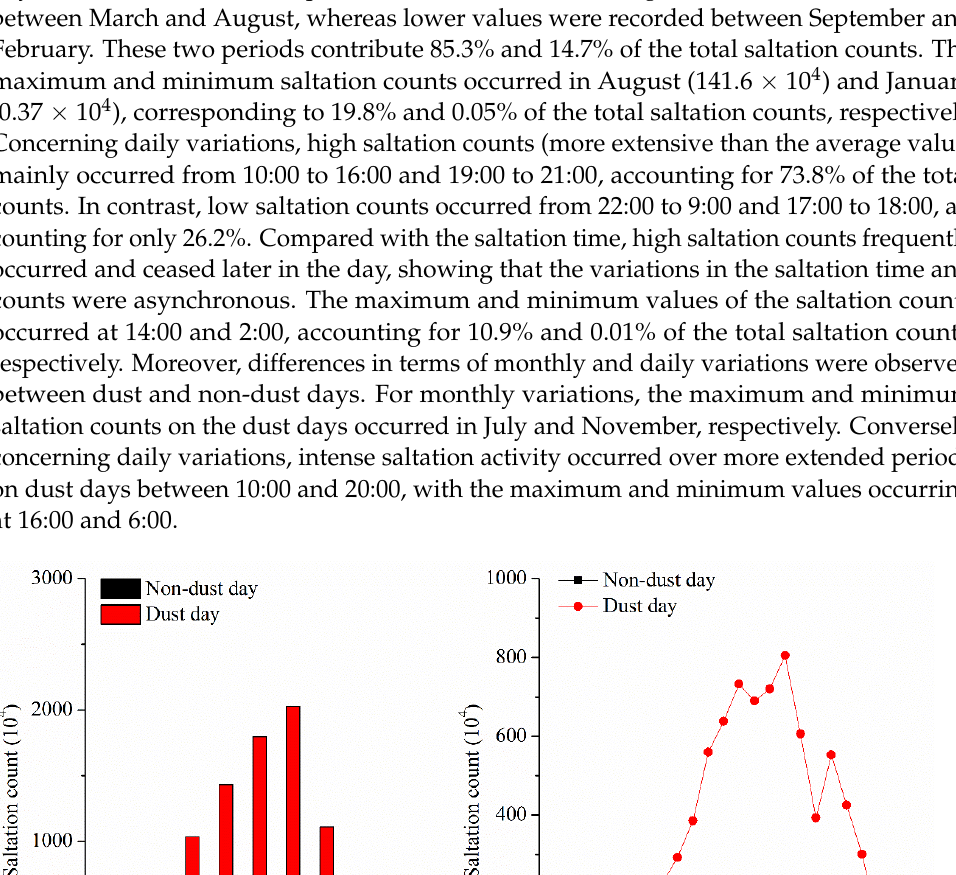
non-dust days. The corresponding values for dust days were only 47.7% and 56.4%, re- spectively.